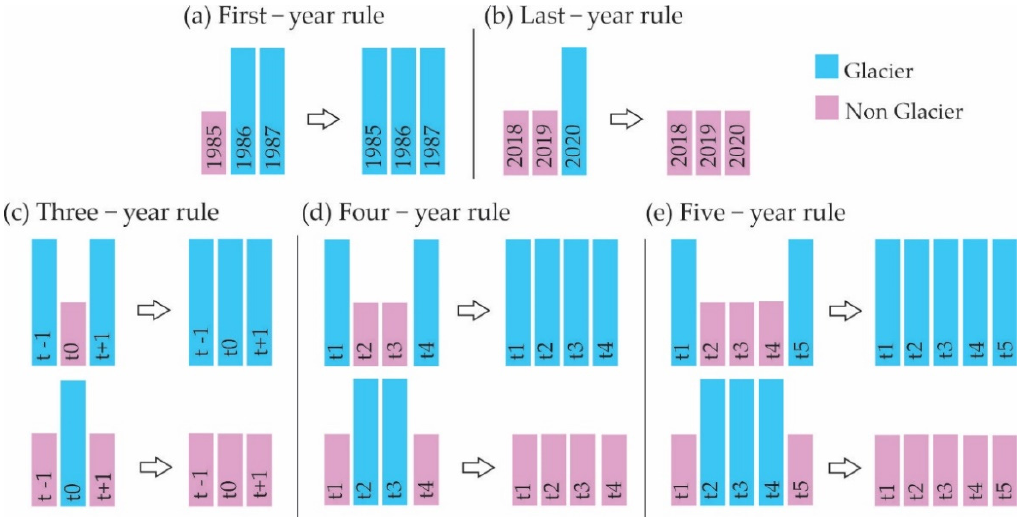
Figure 7. Effect of the temporal filter application for each rule: ( a ) first ‐ year rule, applied only to the year 1985; ( b ) last ‐ year rule, applied only to the year 2020; intermediate ‐ year rules with ( c ) a three ‐ year moving window; ( d ) a four ‐ year moving window; and ( e ) a five ‐ year moving window. The first ‐ and last ‐ year rules maintain class continuity at the beginning and end of the series, while the intermediate rules identify the inconsistent transitions and correct them, such as the sudden appear ‐